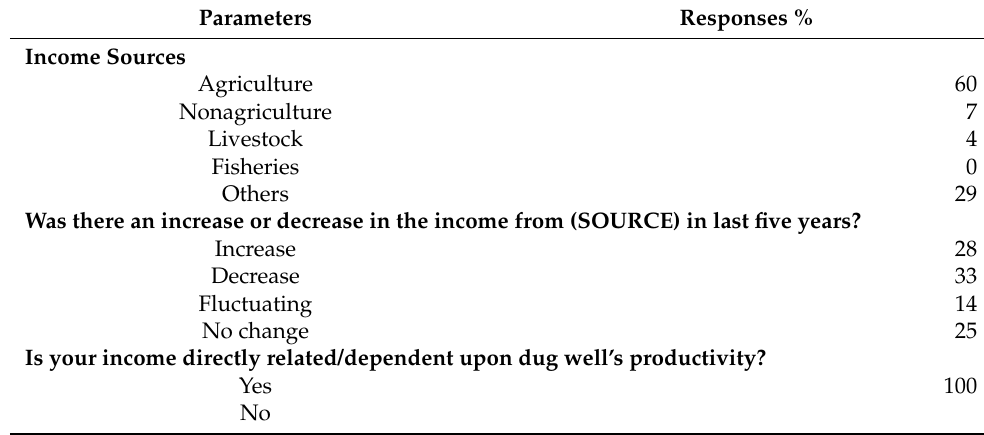
Table 2. Household